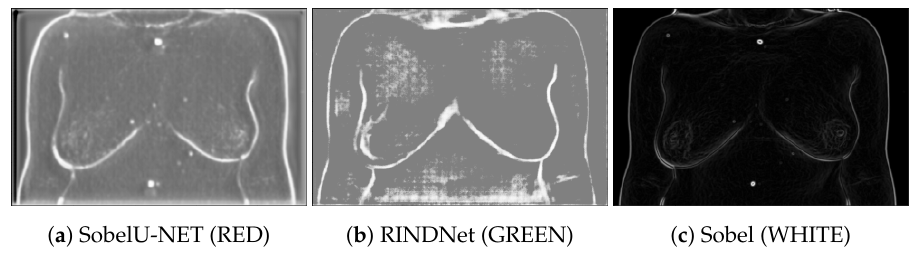
Figure 4. Example of the output of Sobel U-NET ( a ) RINDNet ( b ) and the Sobel Filter ( c